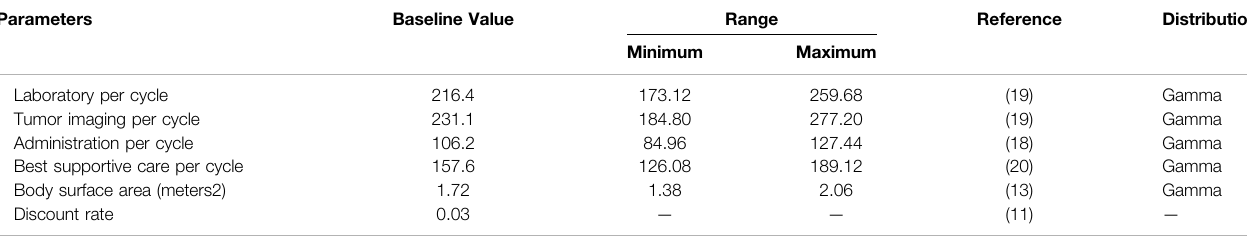
TABLE 1 | ( Continued ) Model parameters: baseline values, ranges, and distributions for sensitivity